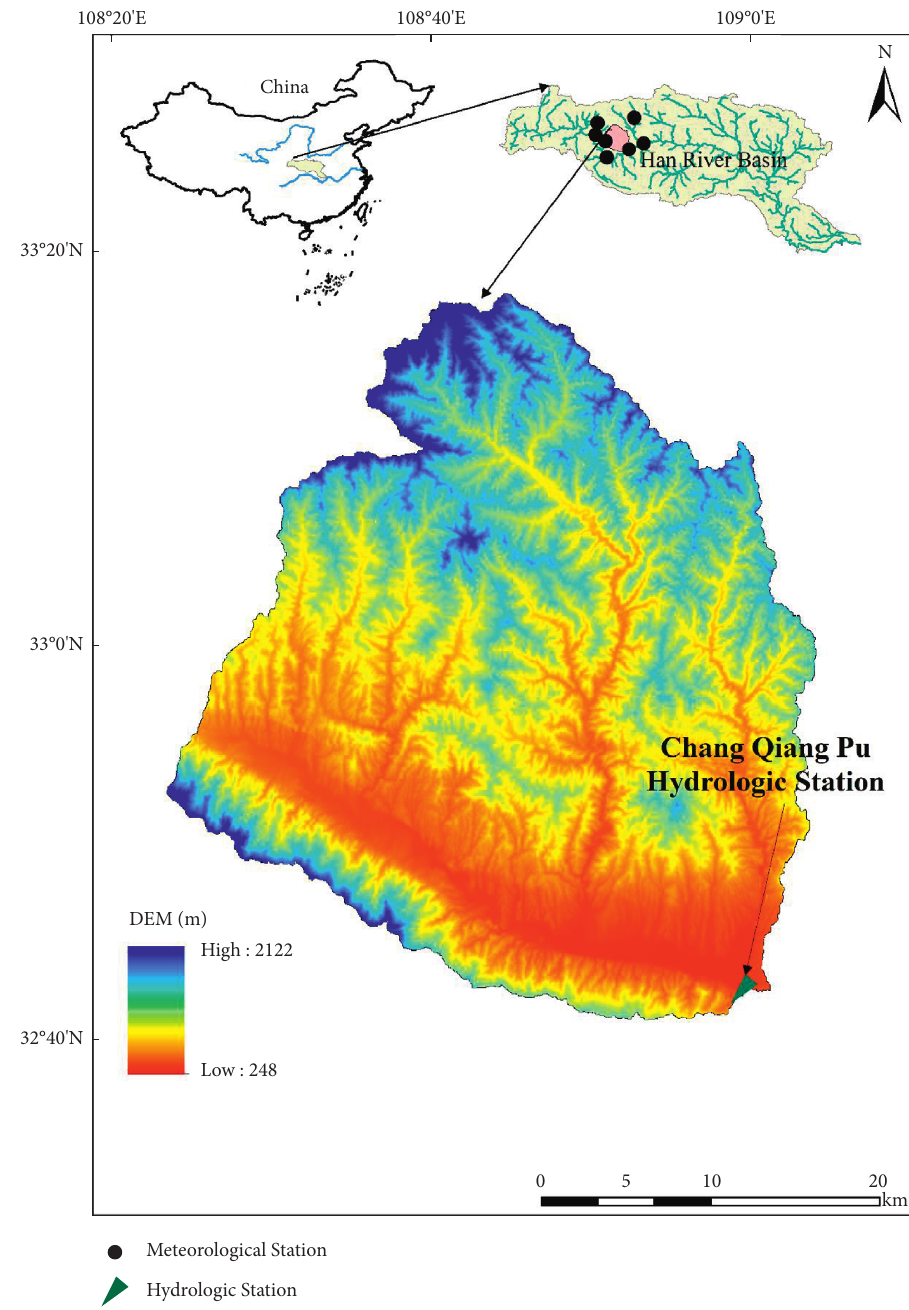
Figure 1: The location of the Yue